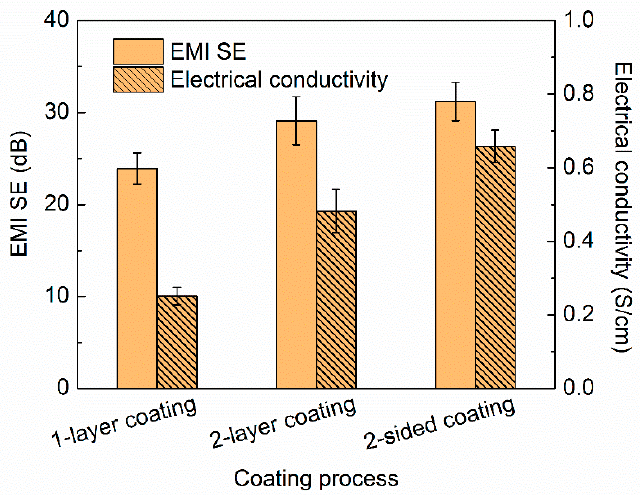
Figure 4. Electromagenetic interference shielding effectiveness (EMI SE) at 1400 MHz and electrical conductivity of composites from various coating processes.